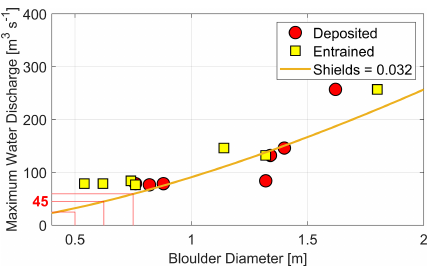
Figure 5. Maximum discharge recorded at the gauge station be- tween two consecutive campaigns as a function of the size of the largest deposited (red dot) or entrained (yellow square) boulder. Or- ange line: fit of the data by Eq.